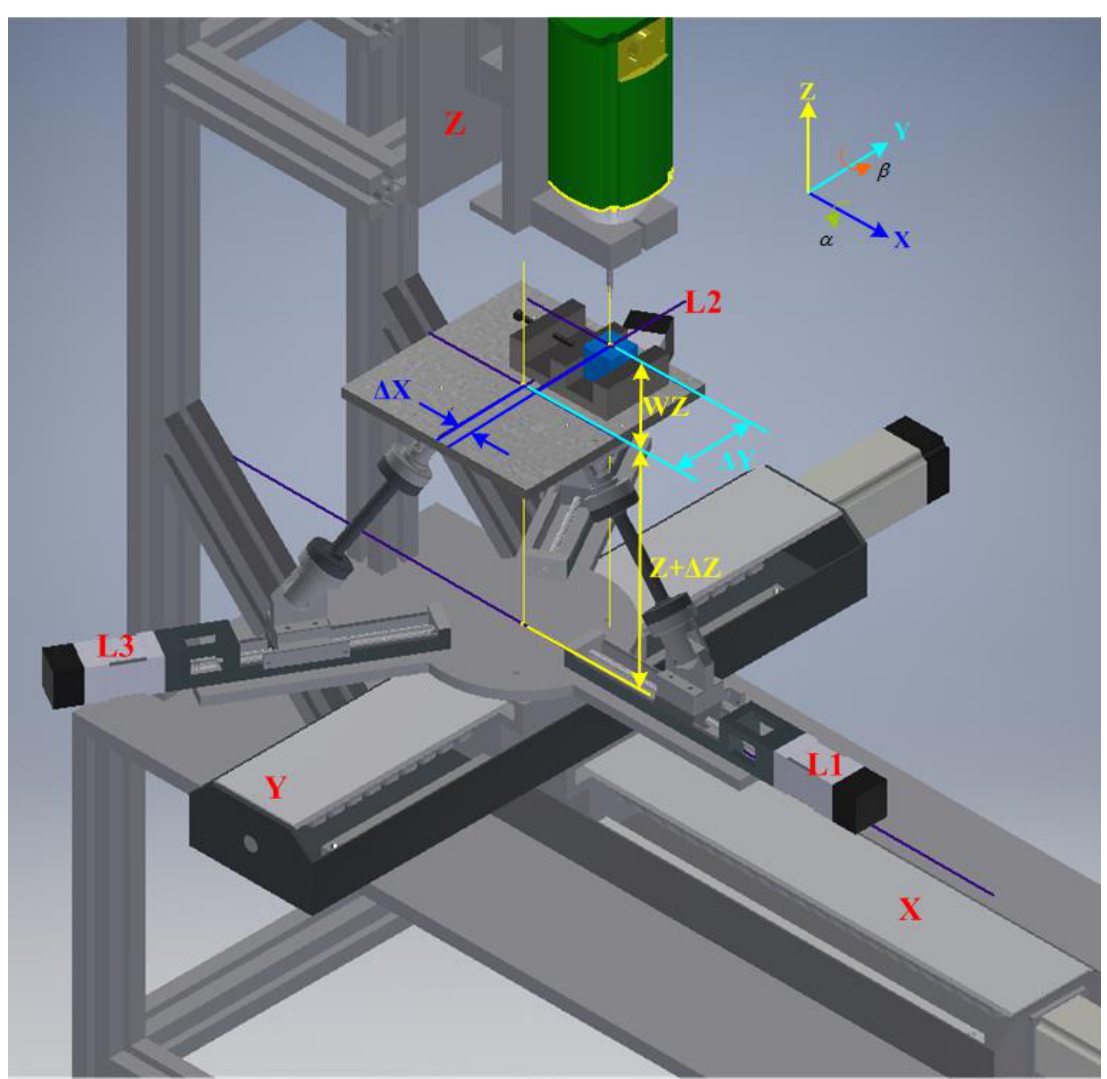
Figure 2. Spatial diagram of a five-axis RPFMT.